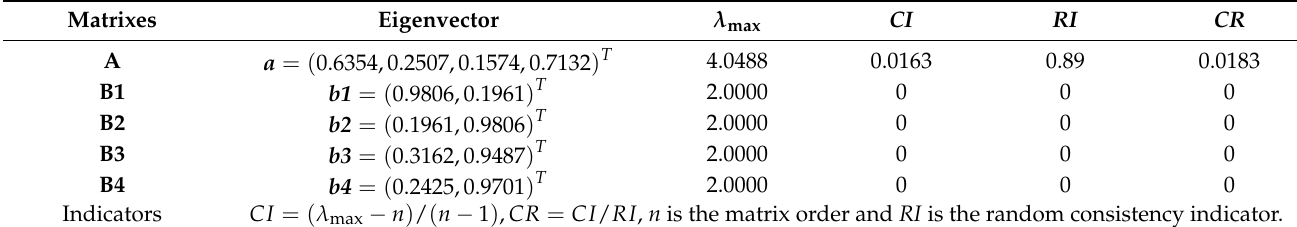
Table 5. Calculation results of the discriminant